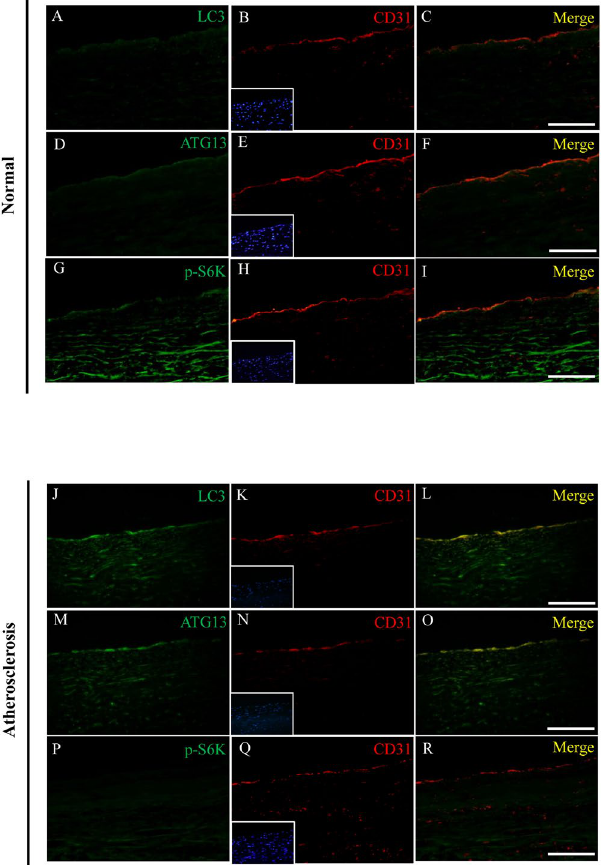
Figure 3. Autophagy is activated in intimal ECs in human atherosclerosis. Representative microscopic images of double immunofluorescent staining for LC3, ATG13 and p-S6K with CD31 (a marker for ECs) in the aortic specimens from a healthy cardiac donor ( A – I ) and a recipient ( J – R ) of heart transplantation for ischemic cardiomyopathy. Nuclei were counterstained with DAPI. Bar = 200 μ